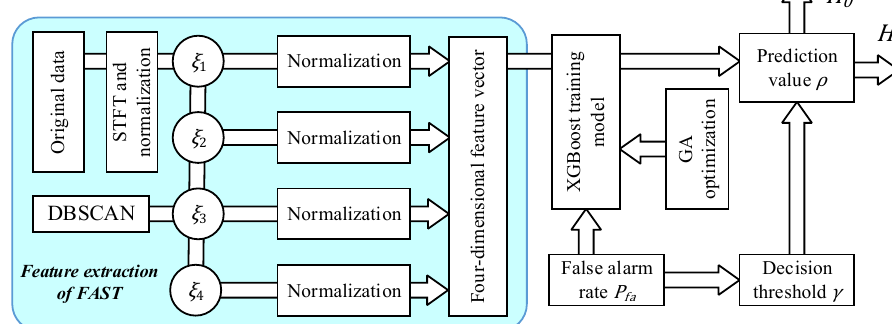
Figure 1. Flowchart of the FAST ‐ 4F detection method.